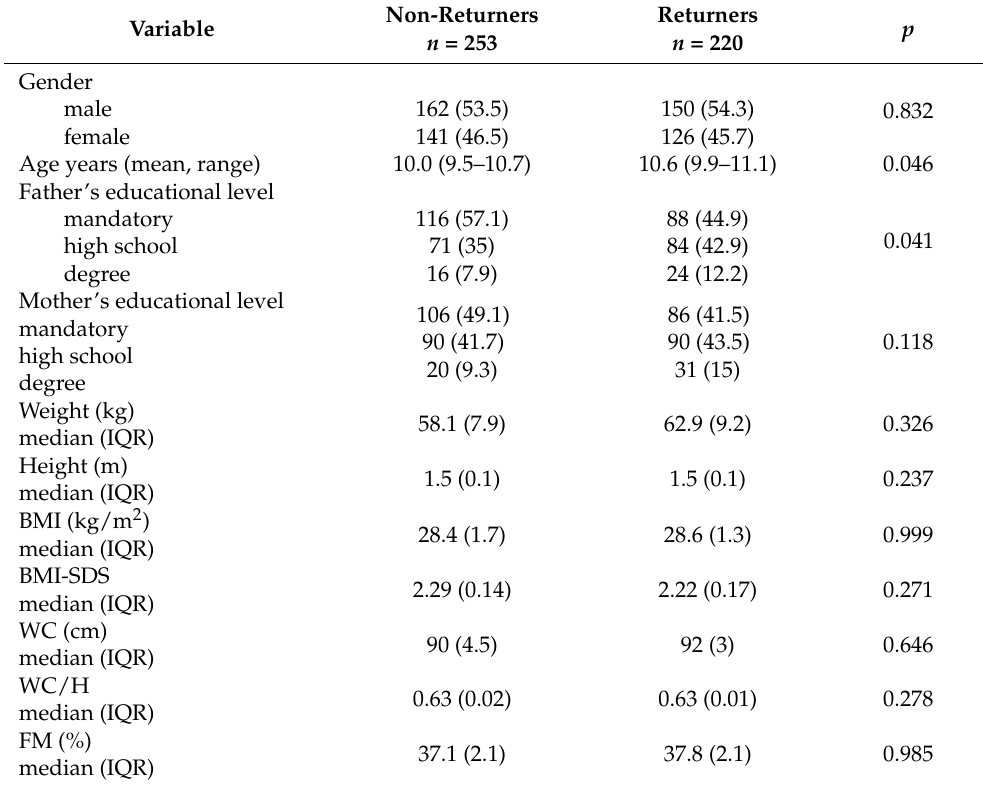
Table 1. Baseline sociodemographic, anthropometric, and behavioral characteristics of subjects who returned or not at the follow-up